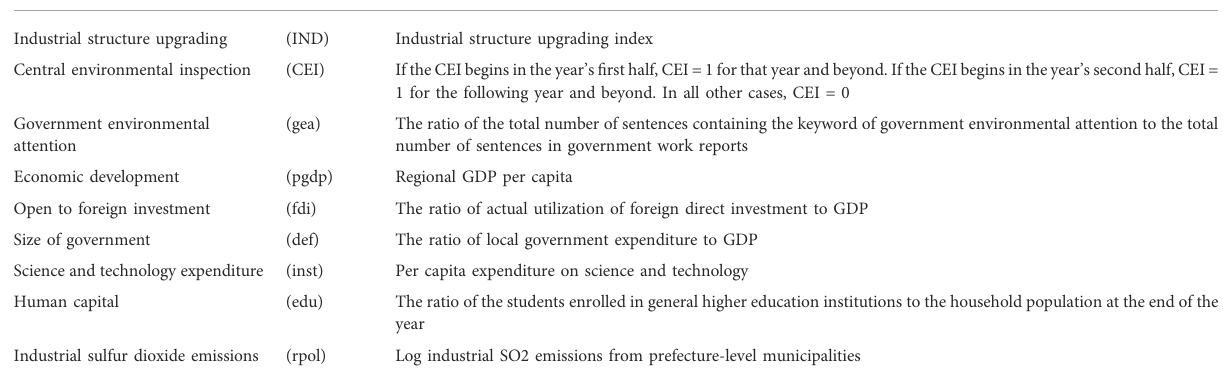
TABLE 1 Measurements of